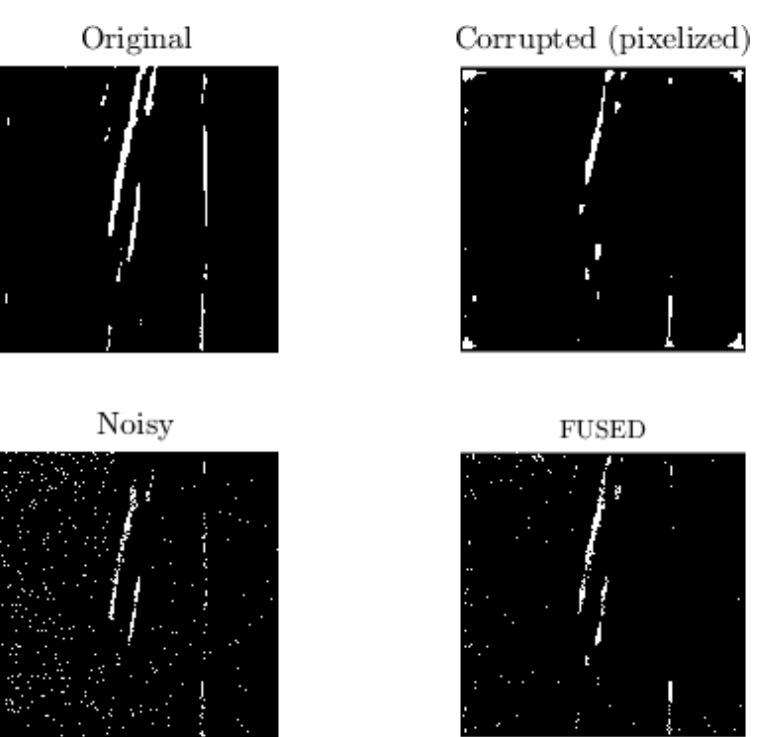
Figure 13. Simple segmentation via the adaptive threshold of the grayscale images from Figure